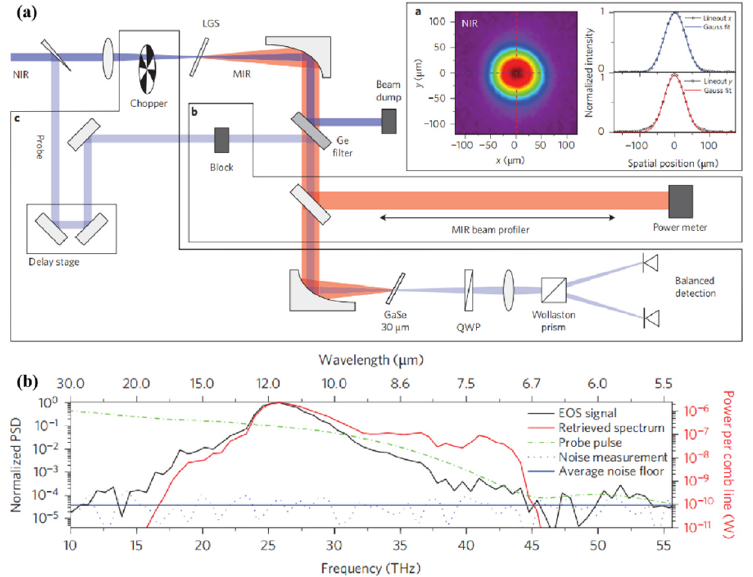
Figure 15. ( a ) MIR generation and detection setup. ( b ) Normalized PSD of the Fourier transforms for the EOS time-domain trace of the retrieved field and of the NIR probe pulse. The dynamic measurement range, determined as the peak of the signal PSD divided by the average detector noise floor (blue, continuous line), was 2.7 × 10 4 . The absolute power per comb line of the generated MIR radiation, obtained by calibrating the normalized PSD of the retrieved MIR power spectrum by the independently measured total power and considering the pulse repetition frequency, is shown on the right axis. Reprinted with permission from [59].